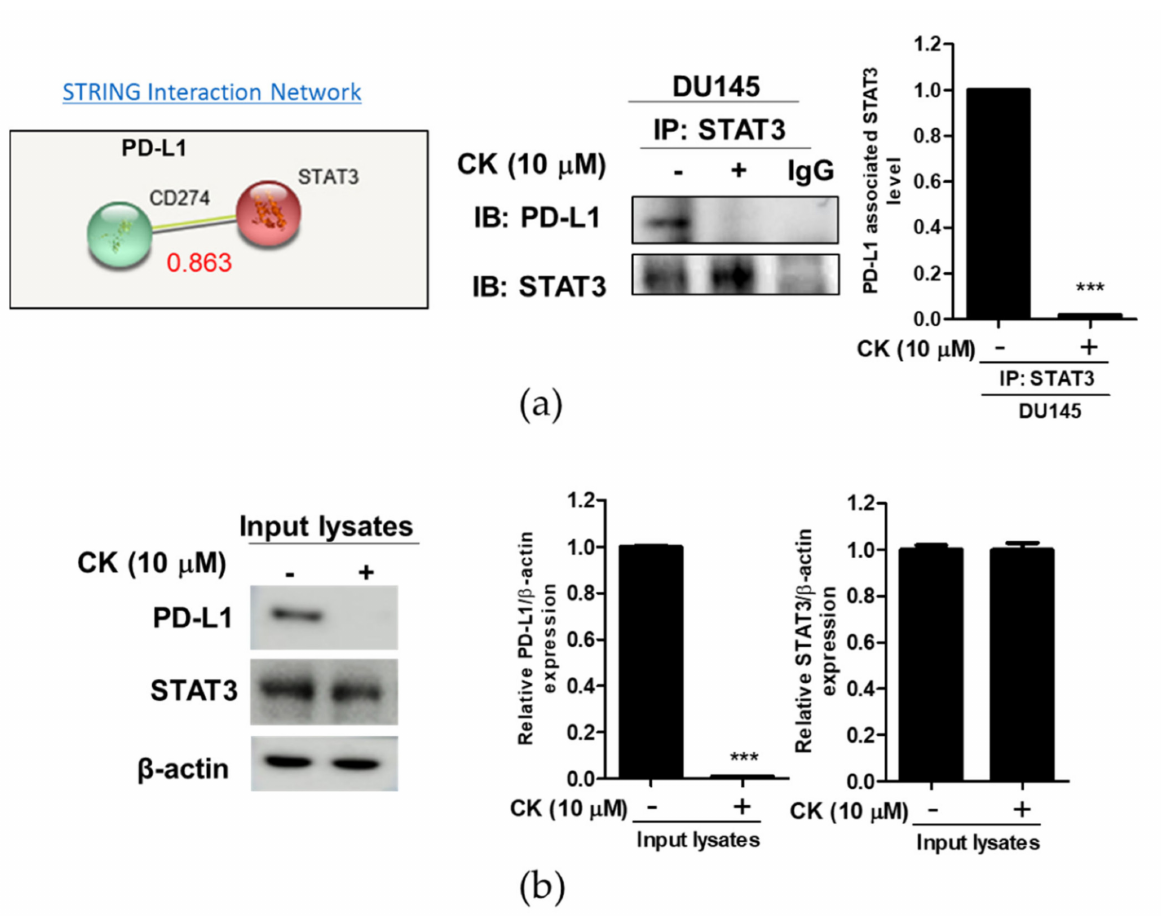
Figure 7. Effect of compound K on the interaction between STAT3 and PD-L1 in DU145 cells. ( a ) STAT3 interacts with PD-L1 by STRING database (interaction score: 0.863). Programmed death-ligand 1 (PD-L1) is also known as a cluster of differentiation 274 (CD274). ( b ) DU145 cells were treated with CK for 24 h and subjected to immunoprecipitation (IP) by using thelysates of DU145 cells with anti-STAT3 antibody or negative control IgG, and then Western blotting to detect PD-L1 in whole-cell lysates. Graphs show relative levels of protein/ β -actin. Data stand for means ± SD. *** p < 0.001 versus untreated